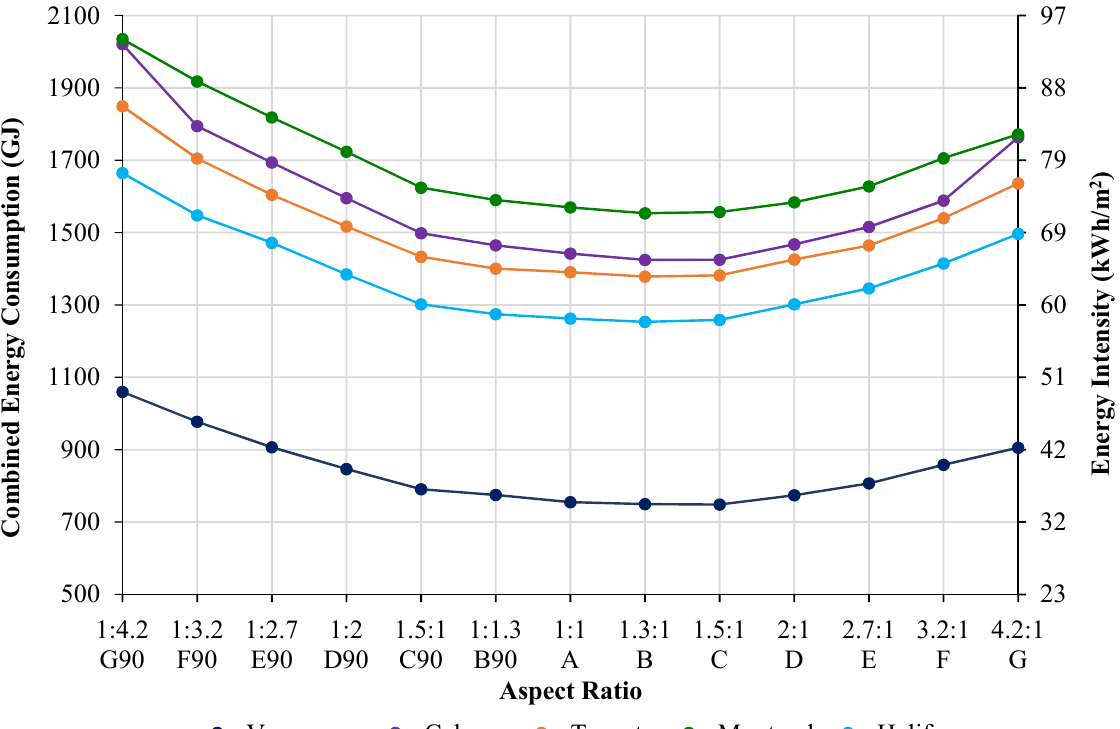
Figure 16. Combined energy consumption and energy intensity for aspect